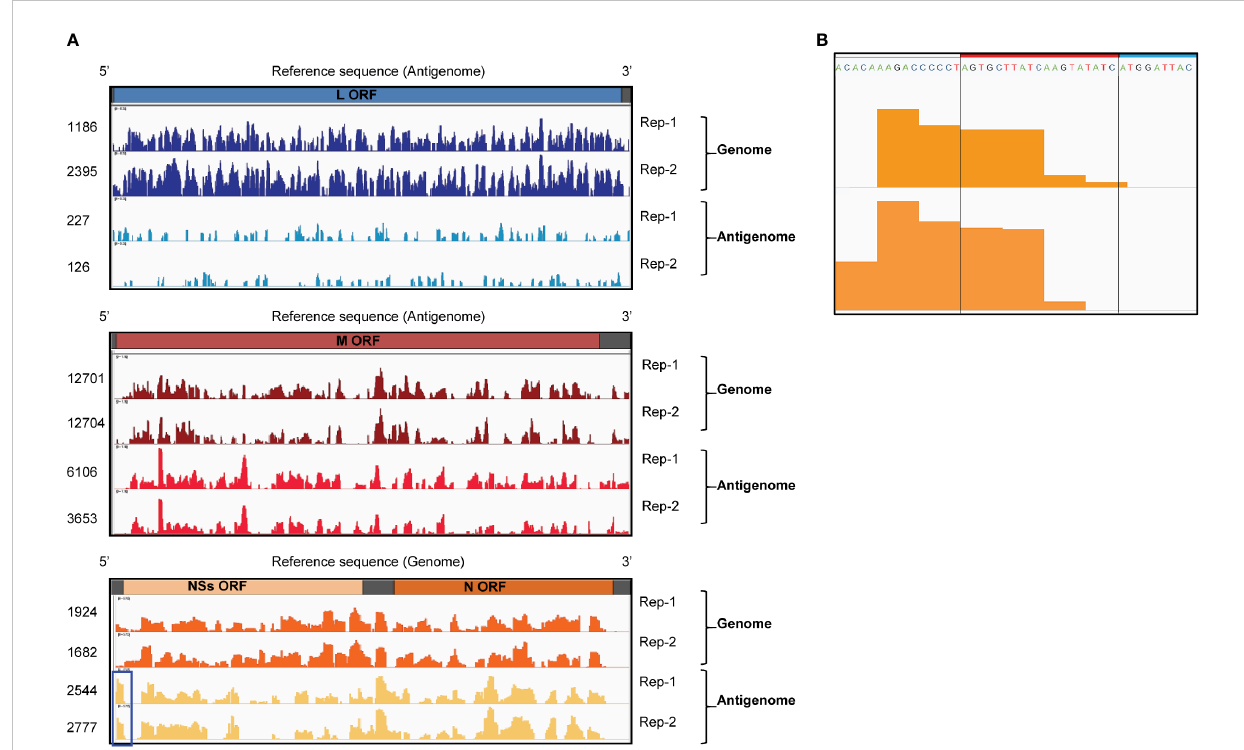
FIGURE 3 CLIP-seq analysis of Gn-binding sites in RVFV RNA segments. (A) CLIP-seq read coverage plots of RVFV genomic and antigenomic RNA segments bound by Gn: L RNA (top plot), M RNA (middle plot), and S RNA (bottom plot). Read coverage plots of immunoprecipitated RNAs were generated after normalization with reads obtained from intracellular RNA (input control). Read coverages of each viral RNA are visualized by Integrative Genomics Viewer and read values are indicated on the left side of the coverage plots. Two independent biological replicates are plotted and designated by Rep-1 and Rep-2. Blue box indicates a prominent peak within the 3 ’ NCR of antigenomic S RNA. ORF = open reading frame (B) The sequence and CLIP-seq read coverage plots (orange-colored areas) of the 3 ’ NCR of the antigenomic S RNA (Rep-1 and Rep-2). The 19 nt region, which is deleted in RVFV D 19, is indicated by a red box and a portion of the NSs ORF is shown by a blue